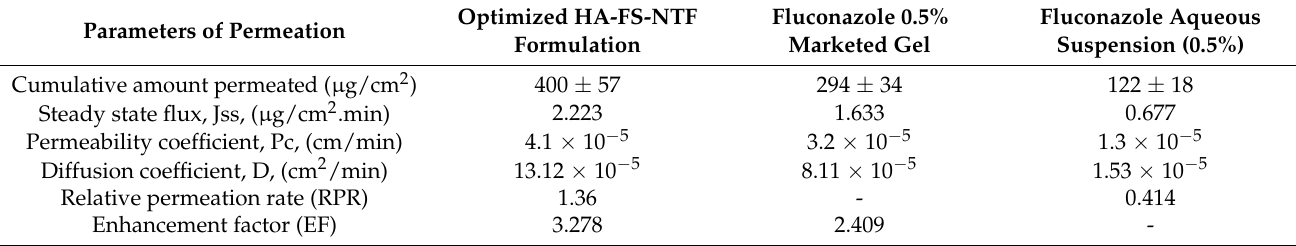
Table 9. Parameters of permeation for fluconazole across the buccal mucosa for different formulations. Optimized HA-FS-NTF Fluconazole 0.5% Fluconazole Aqueous Parameters of Permeation Formulation Marketed Gel Suspension (0.5%) Cumulative amount permeated ( µ g/cm 2 ) 400 ± 57 294 ± 34 122 ± 18 Steady state flux, Jss, ( µ g/cm 2 .min) 2.223 1.633 0.677 Permeability coefficient, Pc, (cm/min) 4.1 × 10 − 5 Diffusion coefficient, D, (cm 2 /min) 13.12 × 10 −